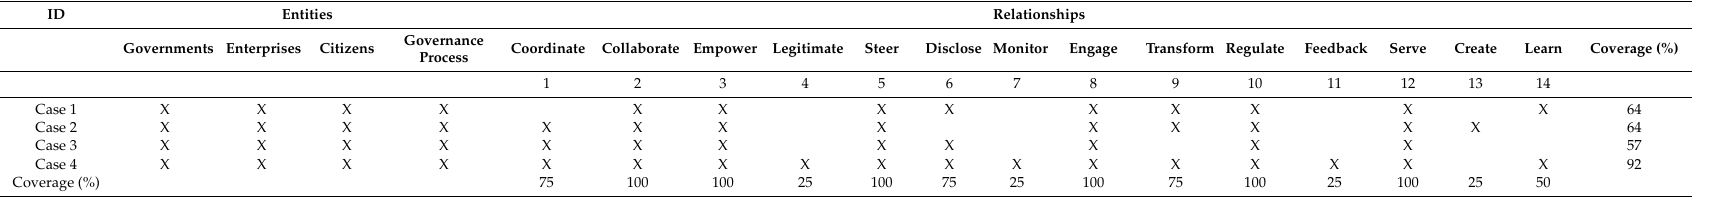
Table 4. Comparative analysis of distribution of government–enterprise